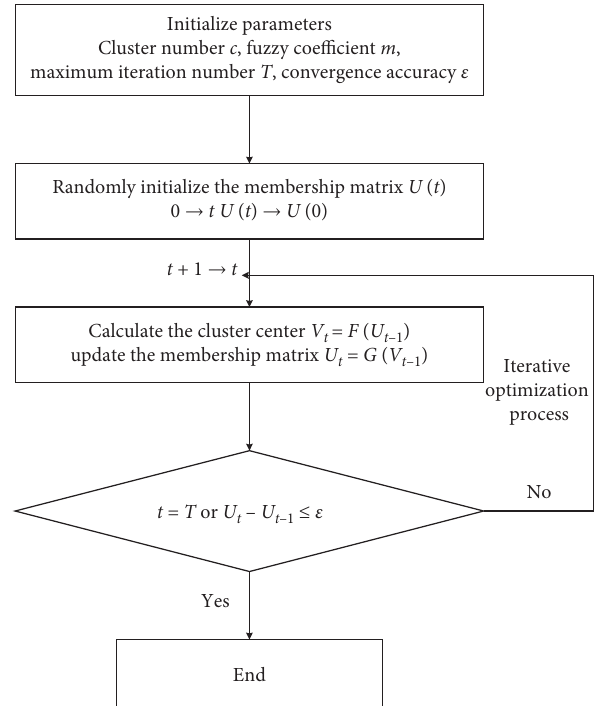
Figure 3: FCM algorithm